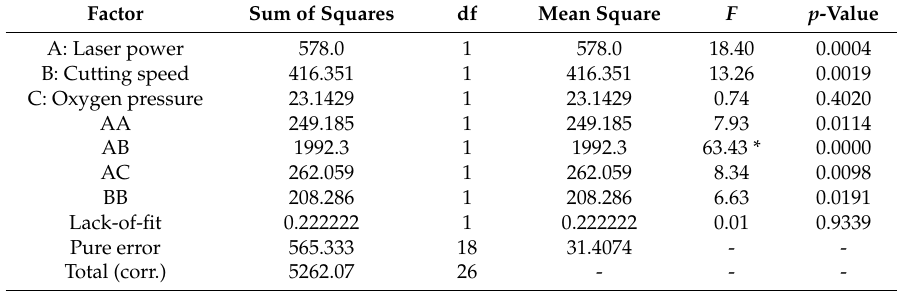
Table 5. ANOVA table for mean height of the surface profile (R Z 5). Asterisk (*) points out the factor with the strongest influence on mean height of the surface profile.